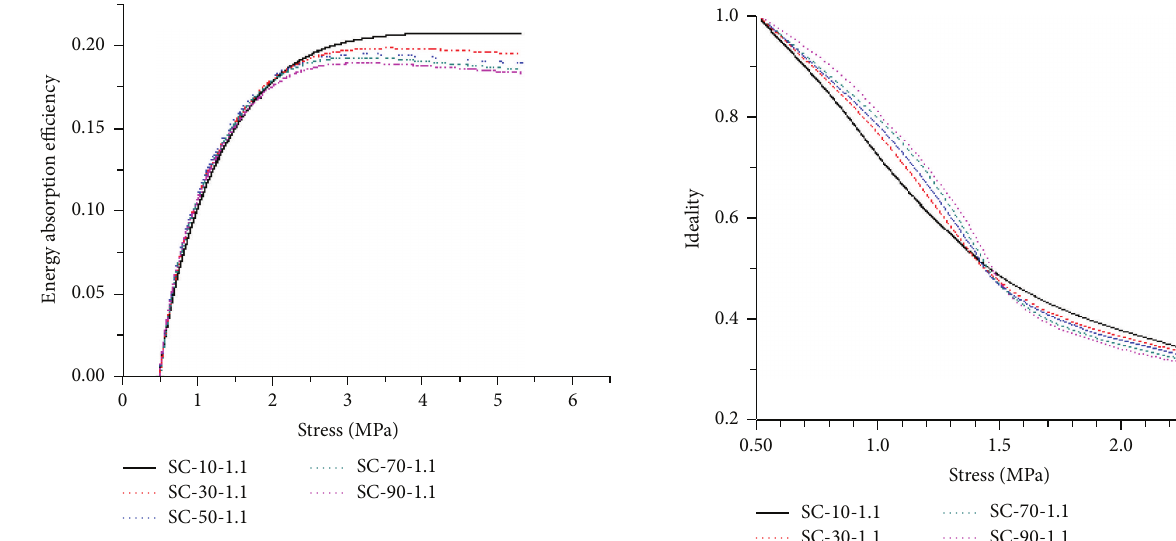
Figure 8: Energy absorption efficiency of the WTDCEs.